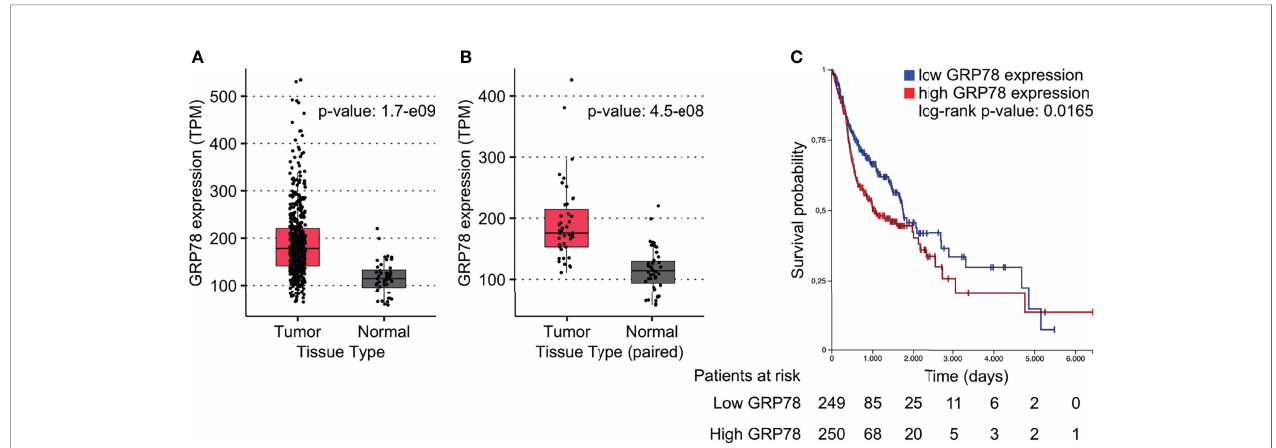
FIGURE 1 | GRP78 expression and outcome in HNSCC patients. (A, B) DEA shows increased GRP78 gene expression in HNSCC tumor tissue (n = 500) in comparison to the non-cancerous tissue samples (n = 44). Data was retrieved from the TCGA database. (B) Comparison of GRP78 expression in paired tumor and non-cancerous tissue samples (n = 43 for both). (C) Kaplan-Meier (KM) survival analysis of HNSCC patients showing decreased survival associated with high GRP78 expression. Survival analysis was evaluated with log-rank test (p =